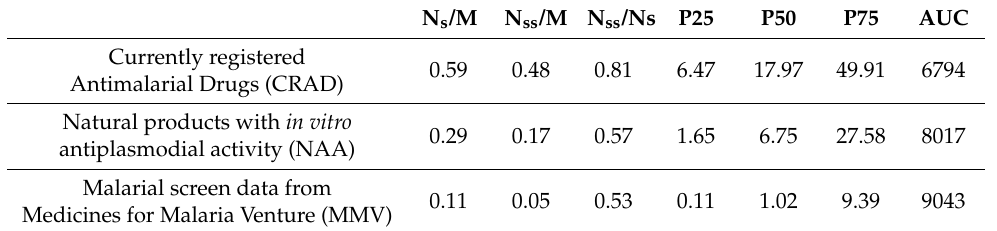
Table 1. Parameters from the scaffold diversity analysis of CRAD, NAA and MMV (using Level 1 scaffolds) 1